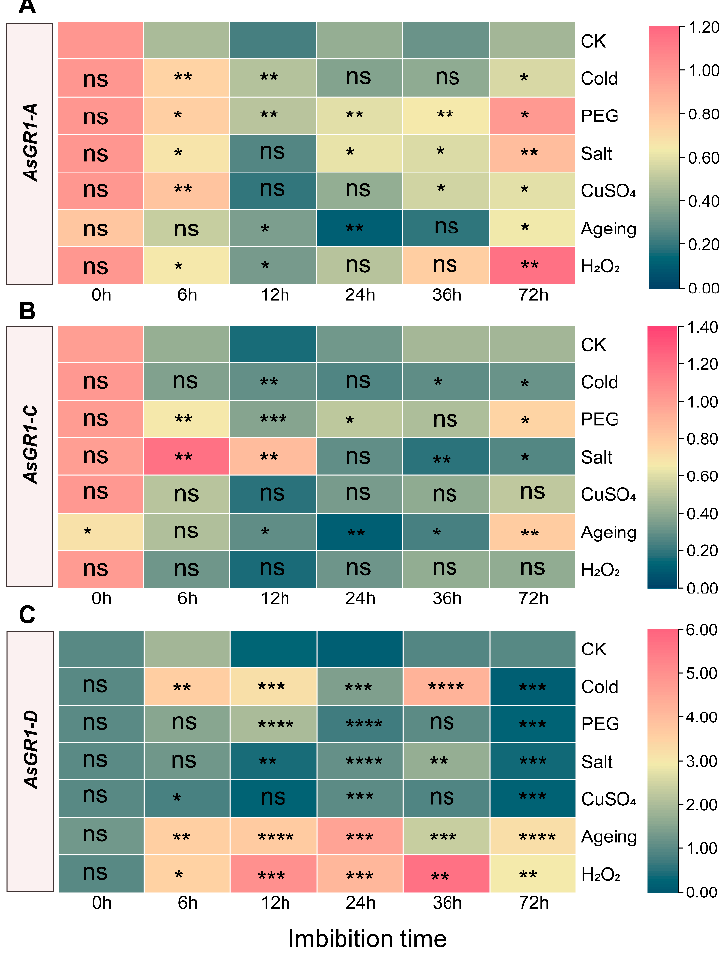
Figure 8. Expression profiling of AsGR1-A ( A ), AsGR1-C ( B ), and AsGR1-D ( C ) during seed imbibition under stress by qPCR. The relative expression was calculated using transcription level of dry seed (0 h) of CK as reference. The significant expression change in comparison to normal conditions (CK) has been calculated using Student’s t test. * indicates a significant difference at p < 0.05; ** indicates a significant difference at p < 0.01; *** indicates a significant difference at p < 0.001; **** indicates a significant difference at p < 0.0001; ns represents not significant.